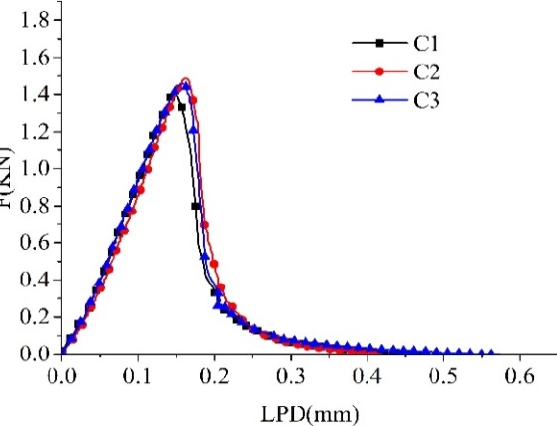
Figure 6. Stress–strain curves measured from experiments. ( a ) Uniaxial compression tests; ( b ) Brazilian splitting tests.